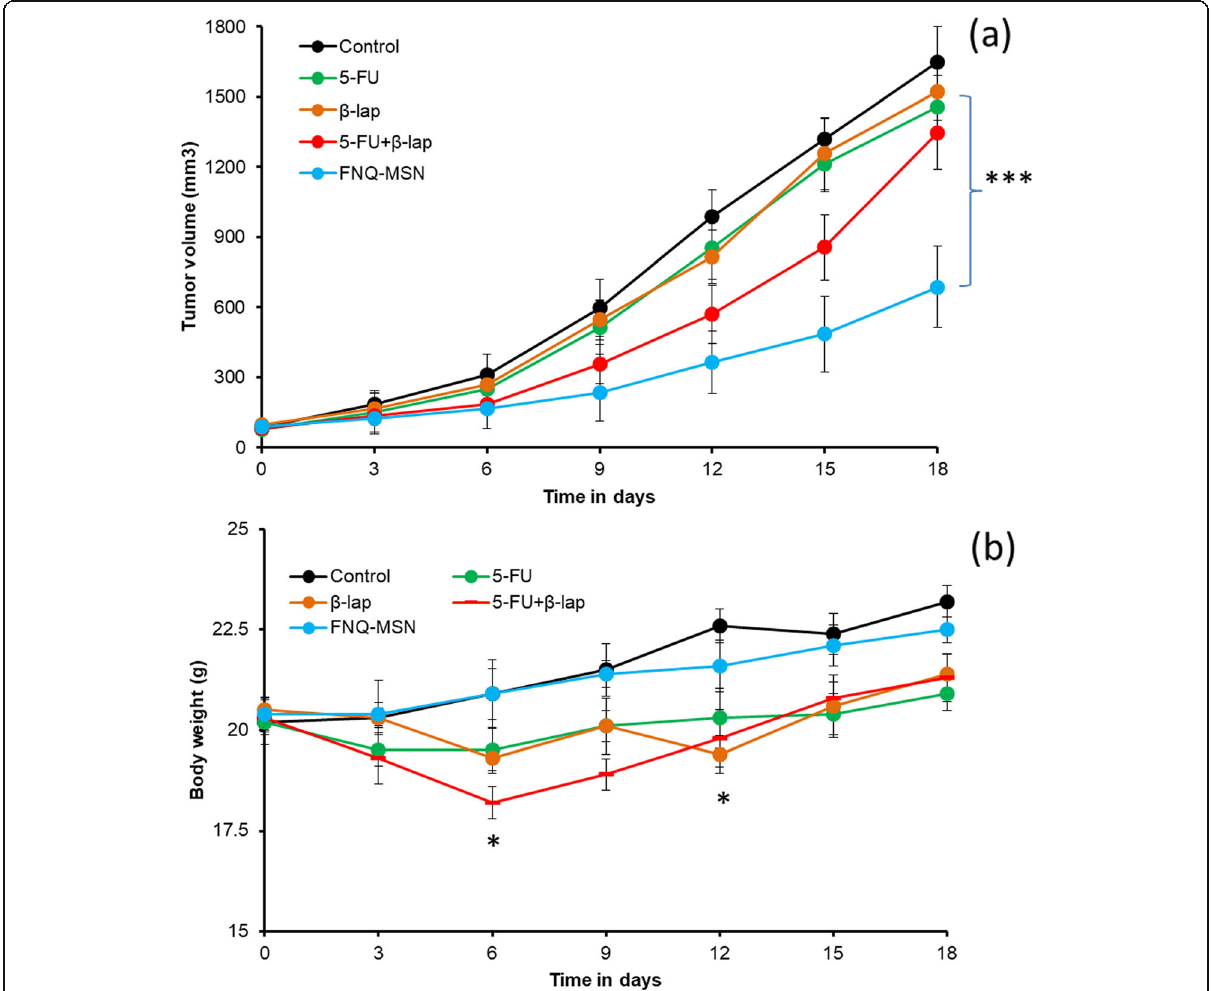
Fig. 8 a In vivo antitumor efficacy of FNQ-MSN in HNSCC xenograft model. The mice bearing HNSCC tumors were treated with 5-FU, ß-lap, 5- FU+ß-lap and FNQ-MSN at a fixed dose of 5 mg/kg of 5-FU and 10 mg/kg of ß-lap intravenously for 3 times. Tumor volume was noted as a part of efficacy analysis and compared with non-treated control. b Body weight analysis corresponding to tumor volume data. * p < 0.05 and *** p <